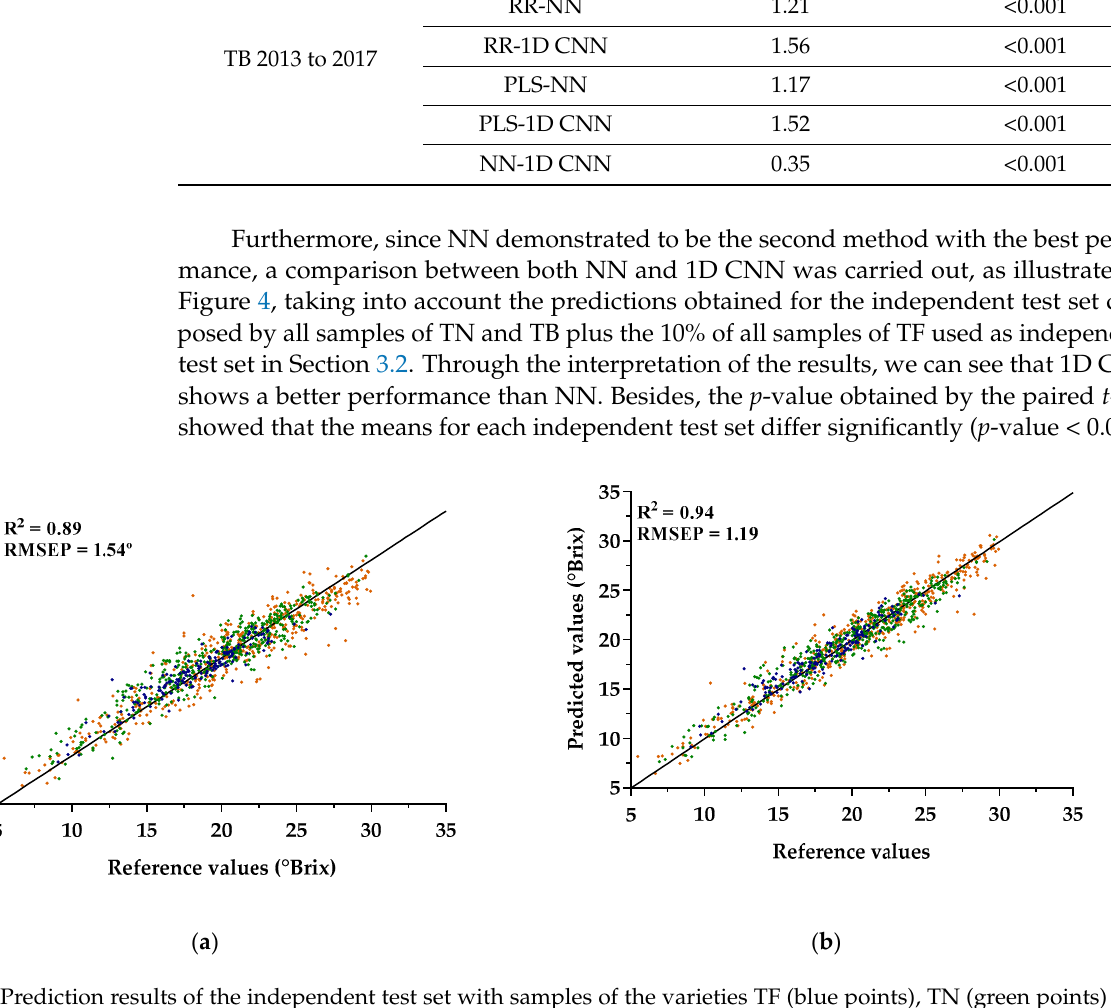
Figure 4. Prediction results of the independent test set with samples of the varieties TF (blue points), TN (green points) and TB (orange points) when applied into the created models with TF samples, regarding: ( a ) neural network; ( b ) one- dimensional convolutional neural